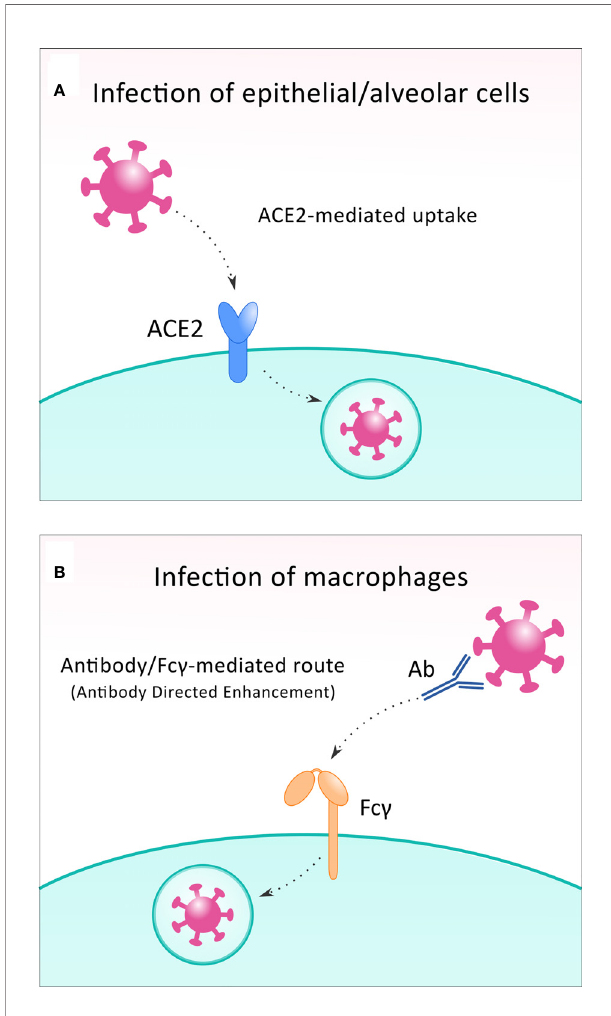
FIGURE 2 | To infect the host cell, SARS-CoV-2 can exploit different receptors. In most infected cells, including epithelial and alveolar cells, the virus binds to ACE2 receptor (A) , while during infection of macrophages, Fc g receptors are utilized in the antibody-directed enhancement mechanism (B)